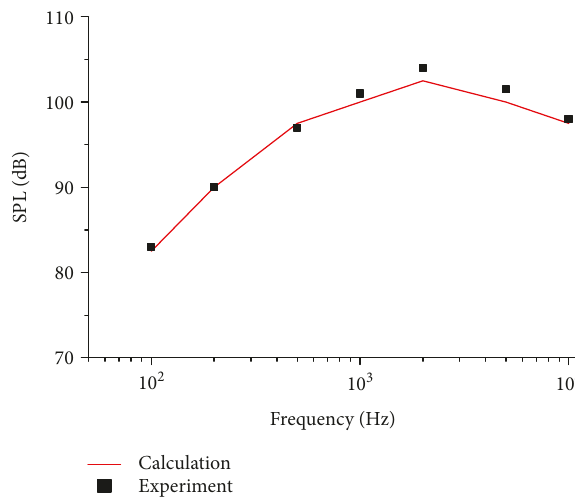
Figure 15: The check of the subsonic jet noise